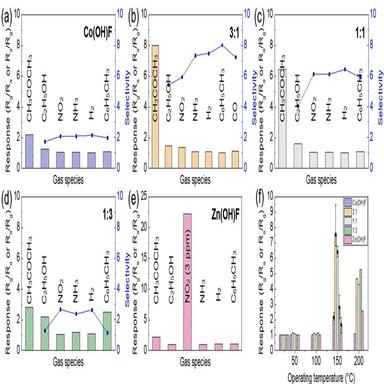
Responses of gas sensors based on (a) the Co(OH)F microflowers, heterostructures with mixing ratios of (b) 3:1, (c) 1:1, (d) 1:3, and (e) Zn(OH)F nanorods toward 5 ppm of CH3COCH3, C2H5OH, NO2, NH3, H2, C6H5CH3, and CO at 150 ◦C (Only the NO2 concentration in the sensing for Zn(OH)F is 3 ppm), and (f) responses of the samples at various operating temperatures toward 5 ppm of acetone gas.